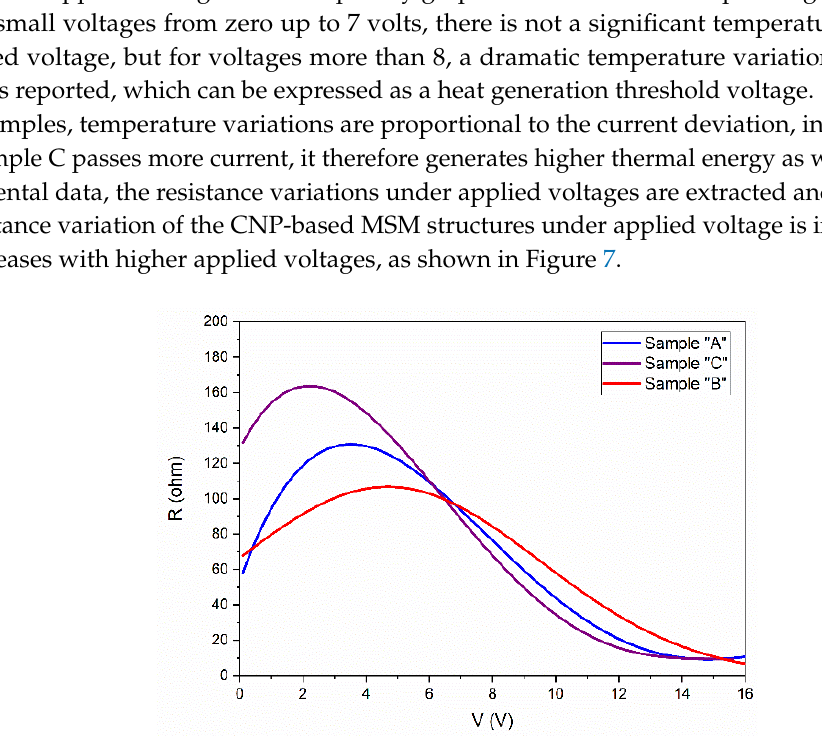
Figure 7. Extracted resistance variation under applied voltage for CNP-based metal–semiconductor– metal (MSM) structures with graphite electrodes.